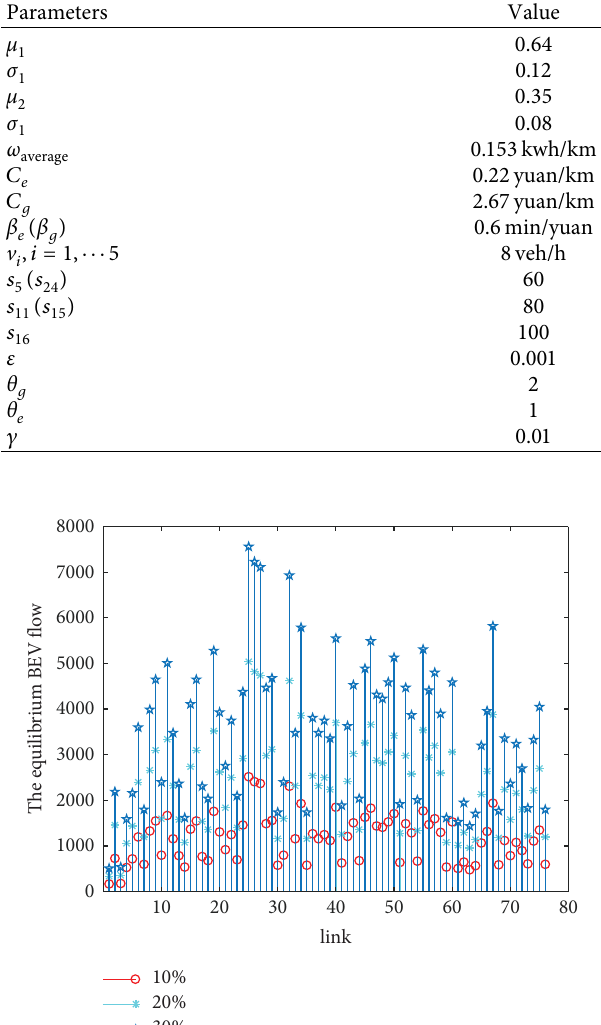
Table 3: Corresponding parameters.